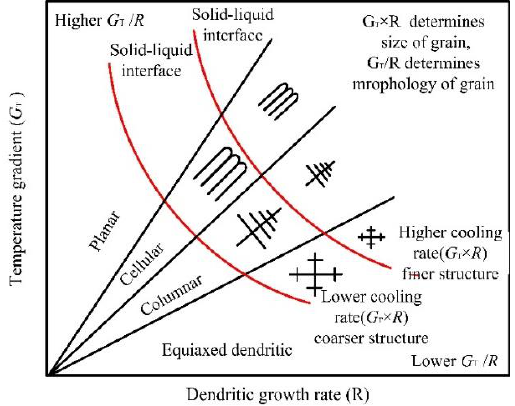
Figure 7. Effect of temperature gradient and dendrite growth rate on grain morphology.